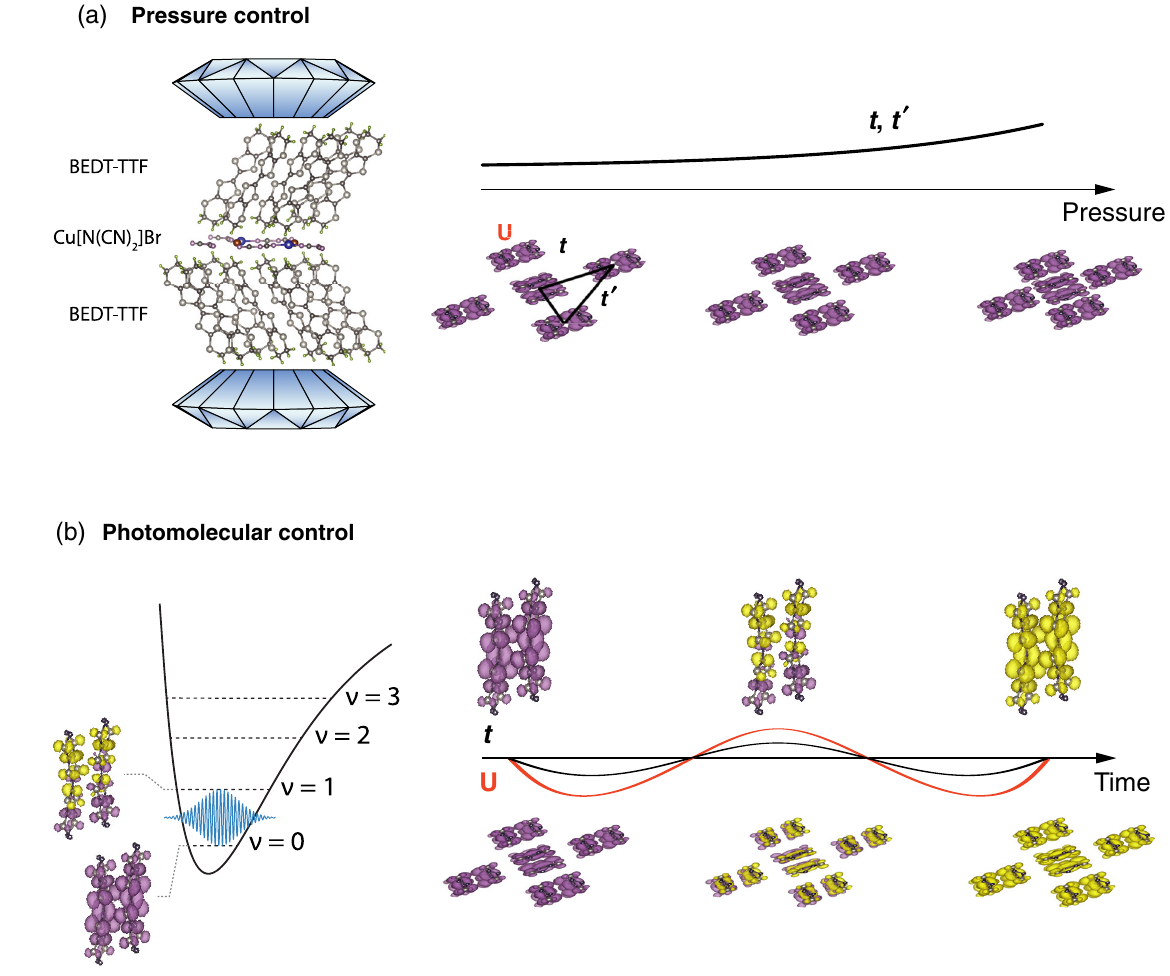
FIG. 1. (a) Left: Crystal structure of κ - ð BEDT (cid:2) TTF Þ 2 Cu ½ N ð CN Þ 2 (cid:3) Br. Alternating blocks of conducting and insulating layers are formed out of donor BEDT-TTF (abbreviated as ET) and polymeric chain-forming acceptor Cu ½ N ð CN Þ 2 (cid:3) Br molecules, respectively. The ET molecules are paired in dimers. Right: View of the pressure-dependent arrangement of the dimers in the κ -phase (visualized along the long axis of the molecules, i.e., top view from left panel). As (external or chemical) pressure is applied, the spacing between dimers changes, thus acting on the transfer integrals ( t , t 0 ) and tuning the ground state of the material. (b) Left: Lennard-Jones potential, along with highest occupied molecular orbital (HOMO) plots for the first two vibrational levels. Violet and yellow colors denote the sign of the wave function. Right: Time evolution of the HOMO after pulsed excitation, creating a mixed population of ν ¼ 1 and ν ¼ 0 states, and the corresponding arrangement of the ET dimers (seen from the top). The periodic changes in the wave function introduce modulations in the on-dimer Hubbard U and transfer integral t , opening new dynamic pathways for controlling the material